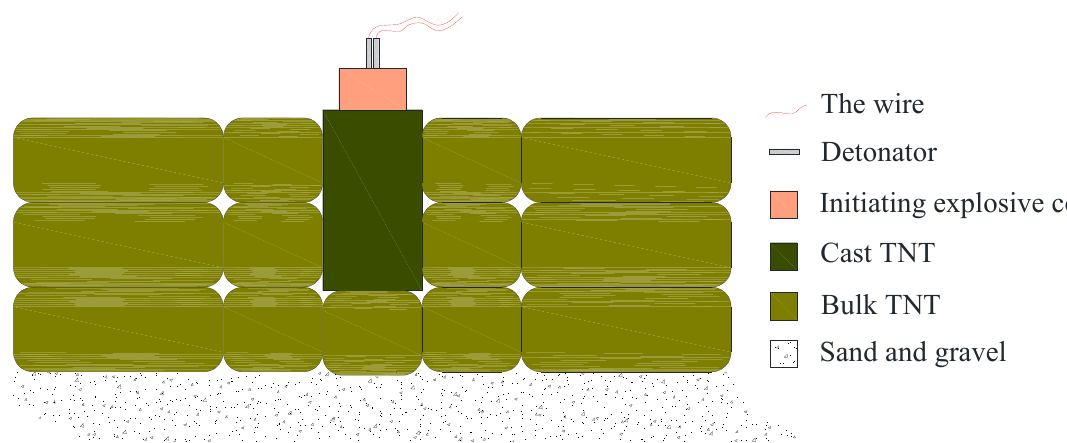
Figure 2. Cross section of explosive arrangement on the ground.